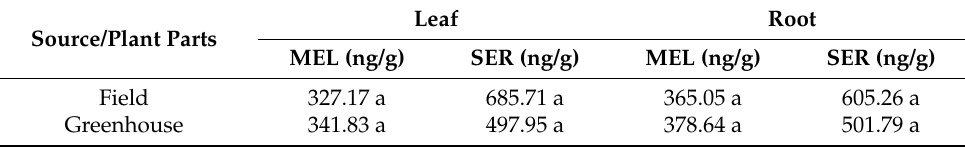
Table 3. Average concentrations of melatonin (ng/g) and serotonin (ng/g) in leaf and root tissues of greenhouse and field grown plants with five biological replications. Columns with same letter indicate no significant difference between field and greenhouse (Tukey’s test, p >